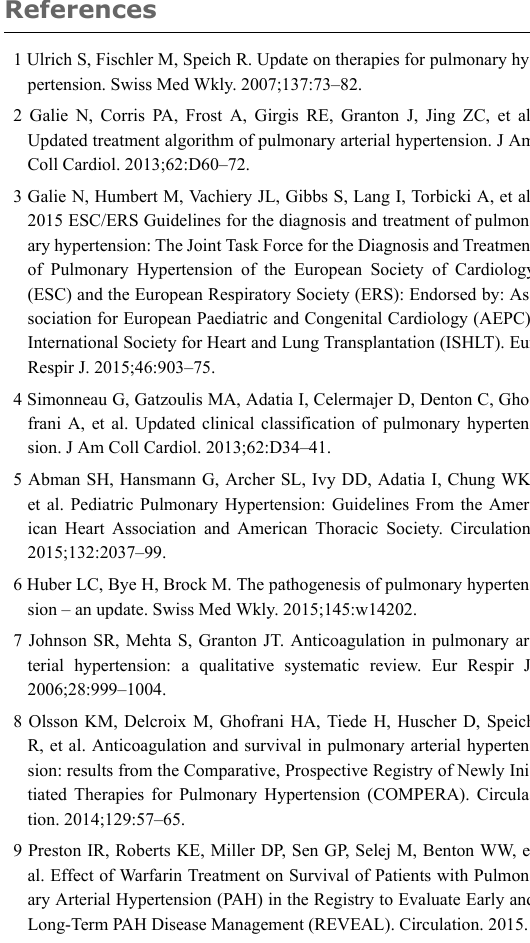
Table 3: Parameters associated with an increased morbidity and mortality risk in pulmonary arterial hypertension. Adapted from refs [3] and [81]. Nonevolving factors PAH associated with connective tissue disorder PAH associated to portal hypertension Heritable pulmonary hypertension Age >60 years and male